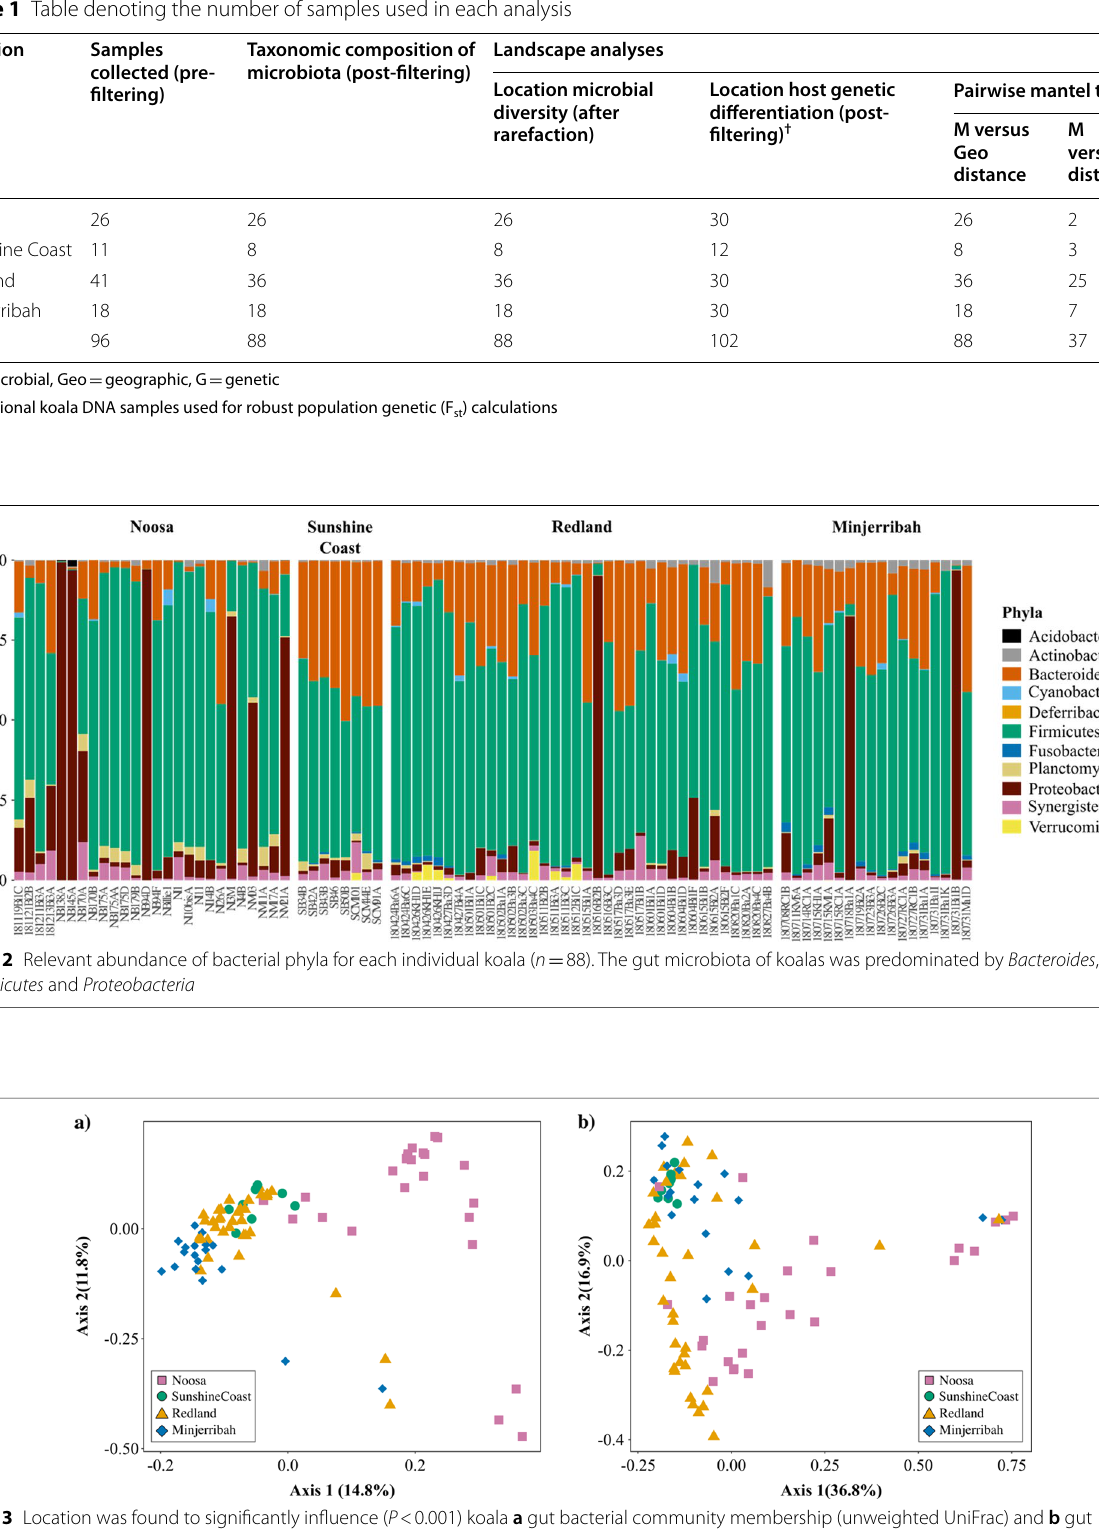
Table 1 Table denoting the number of samples used in each analysis